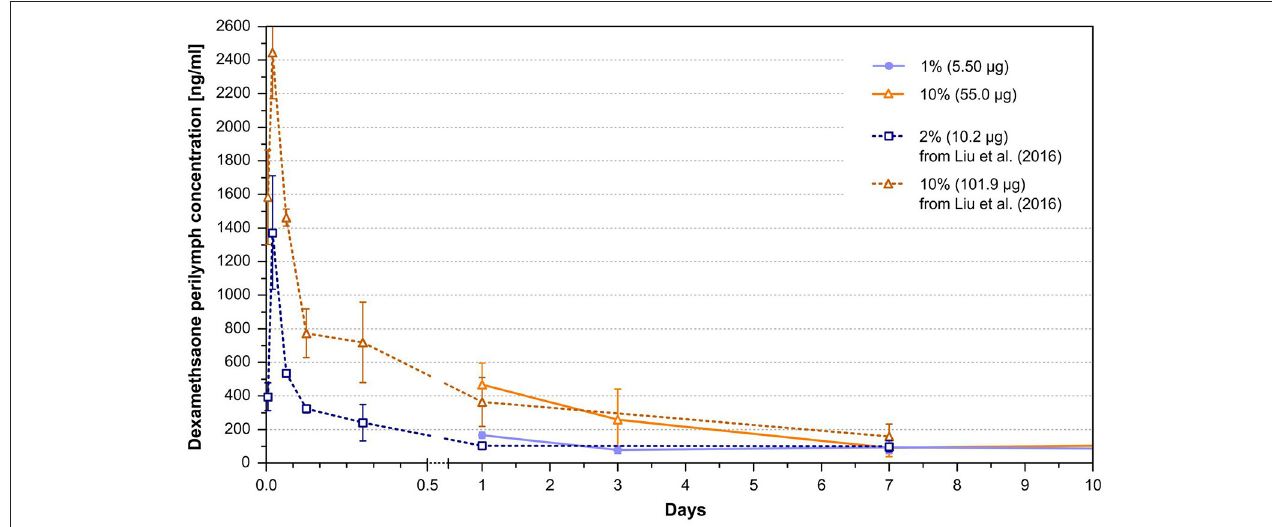
FIGURE 6 | Perilymph dexamethasone concentrations of implanted animals with 5.5 µ g (1%) and 55 µ g (10%) loaded silicone rods after implantation from the current study taken from Figure 4A , and perilymph dexamethasone concentrations of animals implanted with 10.2 µ g (2%) and 101.9 µ g (10%) loaded silicone rods from the study of Liu et al. ( 46). The dexamethasone perilymph concentrations during the overlapping time interval of the studies are similar between the comparable rod